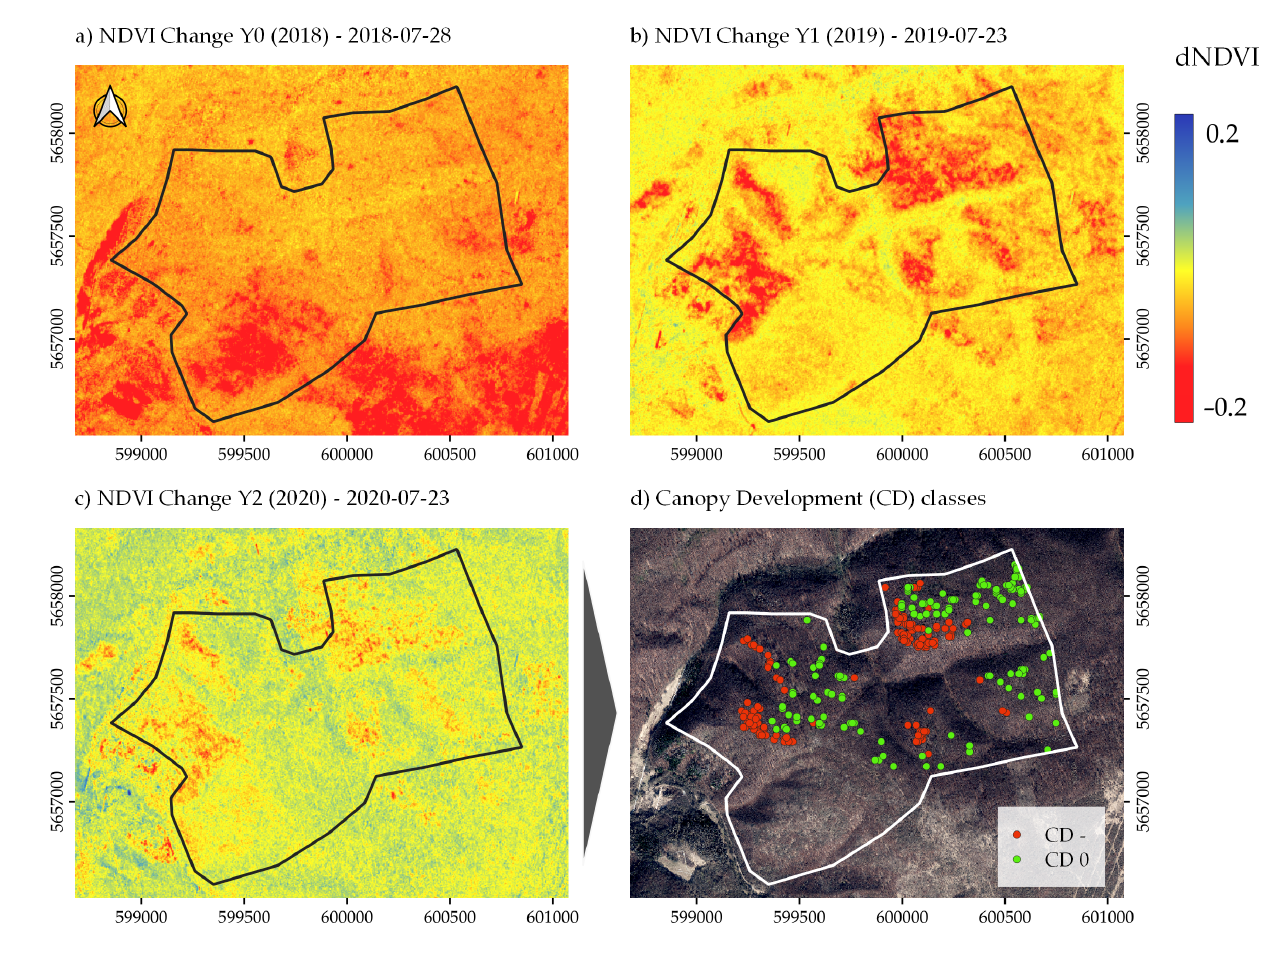
Figure 5. ∆ NDVI of the study area ( a – c ) based on PlanetScope imagery for Y 0 , Y 1 , and Y 2 [56]; ( c ) used to create canopy development (CD) sample sets, see ( d ); CD − (damaged or dead trees), CD0 (undamaged or partially recovered as of Y 2 (2020)), base map aerial imagery from [57]. Acquisition dates for the PlanetScope image pairs are indicated in the figure. Note that PlanetScope radiometry may be inconsistent in the used scenes, impeding quantitative